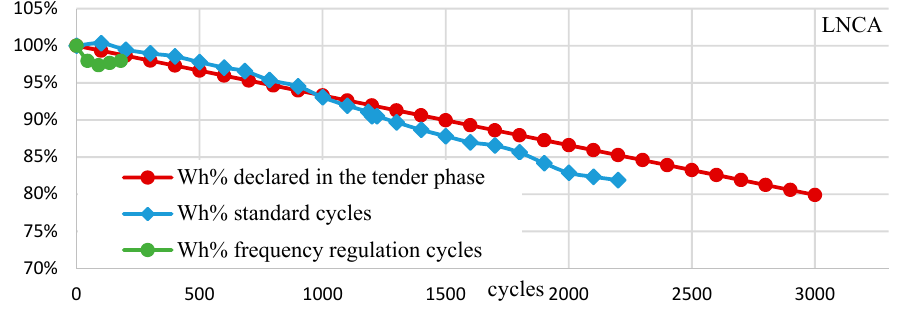
Figure 8. Lithium nickel cobalt manganese (LNCA) technology: comparison between the expected ageing, declared in the tender phase, and the ageing after the standard and frequency regulation cycles.